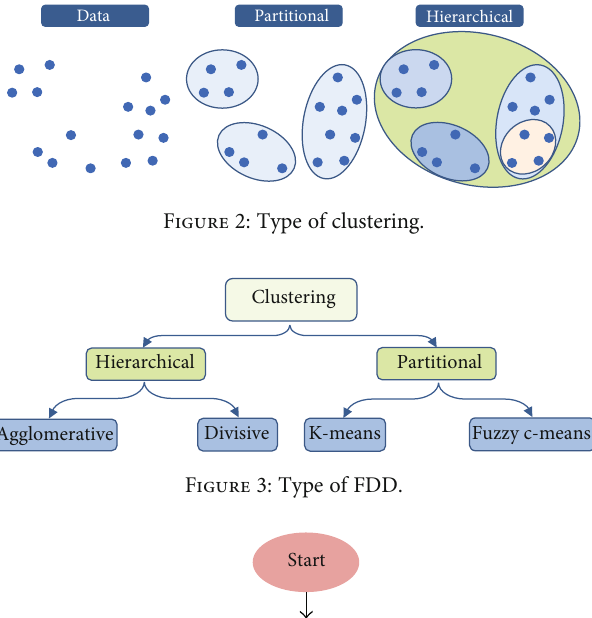
Figure 3: Type of FDD.